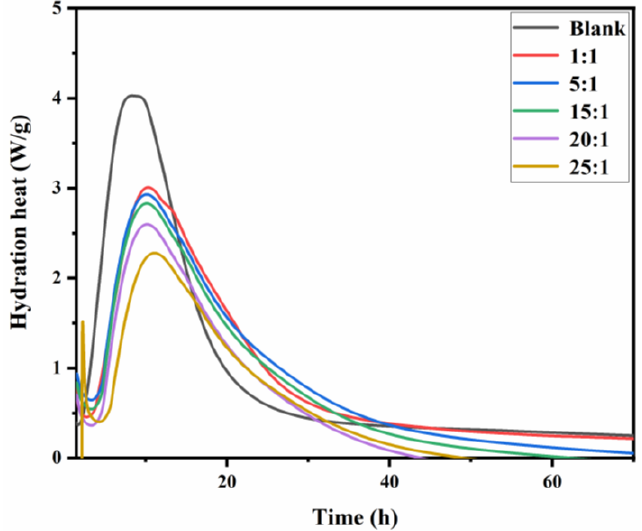
Figure 10. Hydration exothermic curves of cement pastes with or without PBA-g-PDMAEMA.